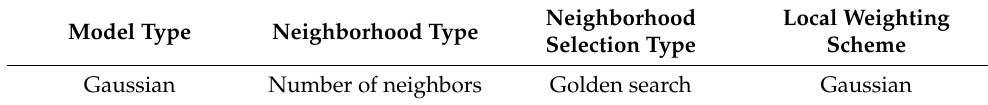
Table 1. GWR model parameters.